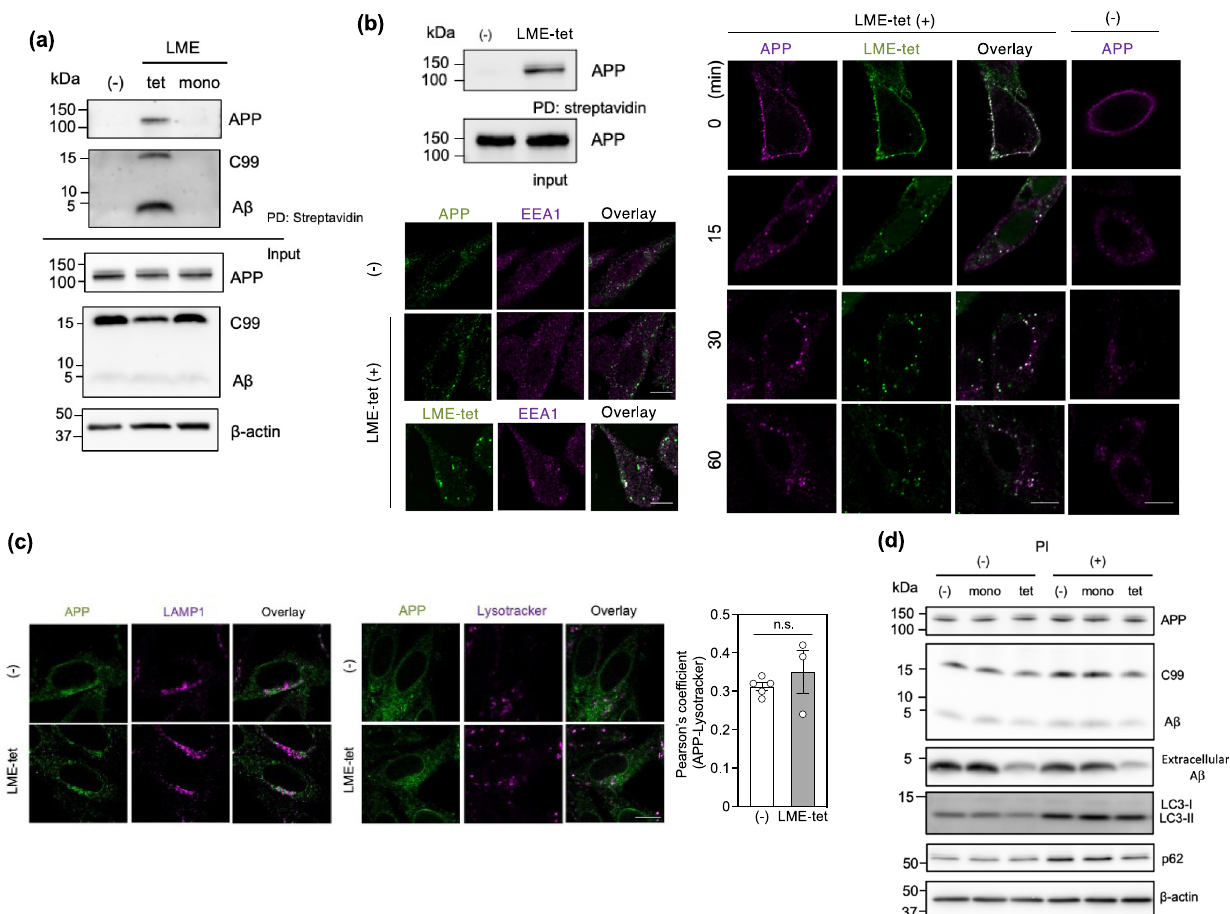
were treated with biotinylated LME-tet (50 µ M) or LME-mono (200 µ M) for 30 min at 37 °C. Cell lysates were then incubated with streptavidin beads, and coprecipitating proteins were analyzed by western blot; PD, pull down. b Binding of LME-tet to APP in the plasma membrane (upper left panel). 7WD10 cells were treated with biotinylated LME-tet (50 µ M) on ice for 30 min, and cell lysates were analyzed as described above. Intracellular localization of APP- LME-tet complex (right panel). 7WD10 cells were treated with mouse monoclonal anti-human APP antibody 6E10 in the presence or absence of biotinylated LME-tet (50 µ M) on ice for 30 min; cells were then washed and incubated at 37 °C for the indicated time. APP was detected by Alexa Fluor 546-conjugated goat anti-mouse IgG antibody, and LME-tet was detected by Alexa Fluor 488-conjugated streptavidin. Colocalization with early endosome antigen 1 (EEA1; lower left panel). 7WD10 cells were treated as described above, and after 15 min incubation at 37 °C, immunostaining for EEA1 was performed using rabbit polyclonal anti-EEA1 antibody, followed by Alexa Fluor 488-conjugated goat anti-rabbit IgG antibody. The scale bars indicate 10 µ m. c APP co-localization with lysosome-associated membrane glycoprotein 1 (LAMP1), a lysosomal marker, was analyzed by immunocytochemical staining with rabbit polyclonal anti-LAMP1 antibody, followed by Alexa Fluor 488-conjugated goat anti-rabbit IgG antibody (left panel). Acidi fi cation of APP- containing endosomes was analyzed using Lysotracker (middle panel). In both cases, 7WD10 cells were treated with or without LME-tet (25 µ M) for 60 min at 37 °C, and APP was detected as described above. The scale bars indicate 10 µ m. Pearson ’ s coef fi cient for colocalization between APP and Lysotracker is shown (right panel; mean ± SE, n (number of cells) = 10 – 24 or 7 – 14, for the absence (-) from fi ve independent experiments or presence of LME-tet from three independent experiments, respectively). Pearson ’ s coef fi cient was calculated using the Coloc 2 plugin in Image J. The signi fi cance vs . LME-tet (-) was calculated using ANOVA, followed by a one-sided Dunnett ’ s test. n.s. not signi fi cant. d Effect of protease inhibitor (PI) on levels of APP, C99, A β , and the autophagosomal markers LC3 and p62, in LME-tet- and LME-mono-treated cells. 7WD10 cells were treated with LME-tet (25 µ M) or LME-mono (100 µ M) in the presence or absence of lysosomal PI cocktail for 48 h. Cell lysates (for intracellular APP, C99, A β , LC3, and p62) and culture medium (for extracellular A β ) were analyzed by western